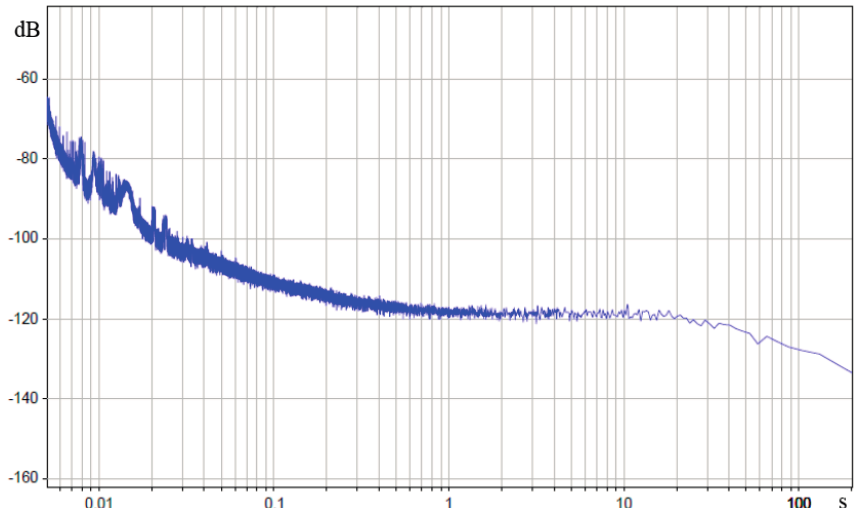
Figure 8. Power spectral density of molecular electronic sensor in units of input angular acceleration in decibels relating to 1 rad/s 2 / √(cid:1834)(cid:1878) , The X-axis is the period in